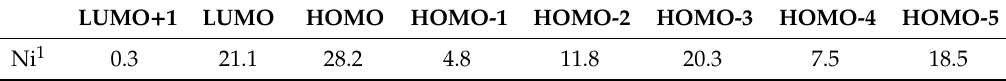
Table 2. Ni(3d), S(3p), and N(2p) Löwdin MO population analysis (%AO to MO) and energies (E, eV) relative to the HOMO for the LUMO+1 through HOMO-5 of the computational model for the disulfide bridged dinuclear {Ni 2 (SOD mds )} nickel site computational model. Orbital compositions for the doubly-protonated model are given above the unprotonated model for each AO. LUMO+1 LUMO HOMO HOMO-1 HOMO-2